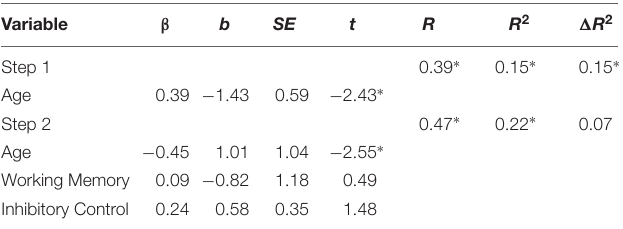
TABLE 8 | Summary of Hierarchical Regression Analysis for variables predicting the number of target actions performed on the high-similarity object in the Distinct Label